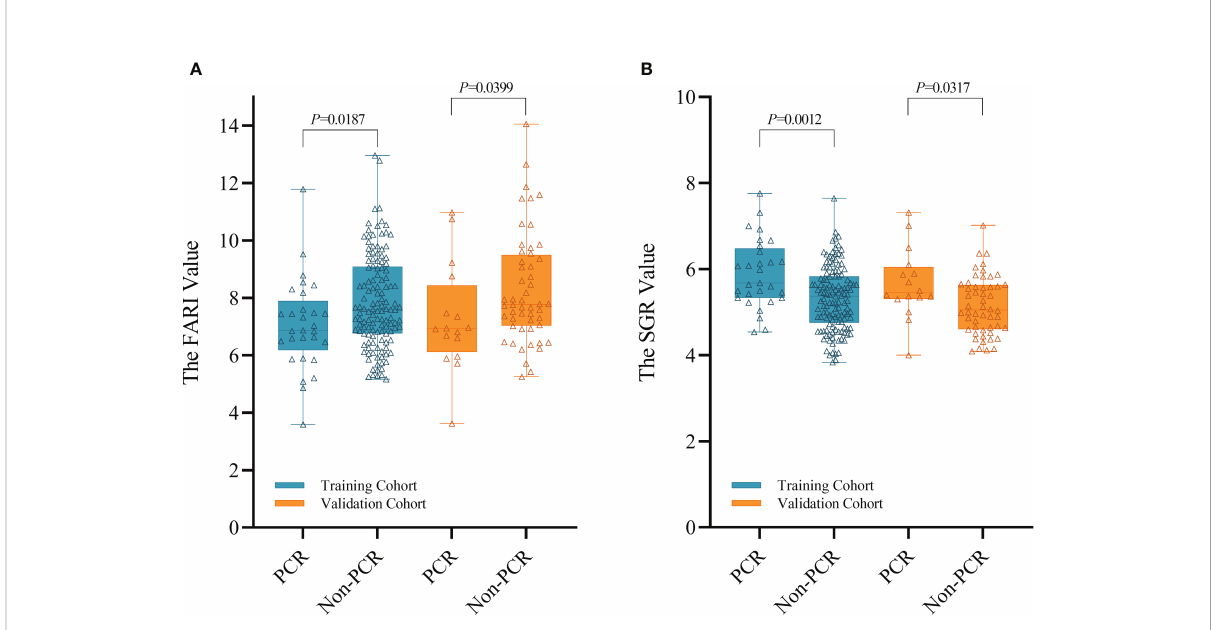
FIGURE 2 Distribution of the FARI (A) and SGR (B) in both